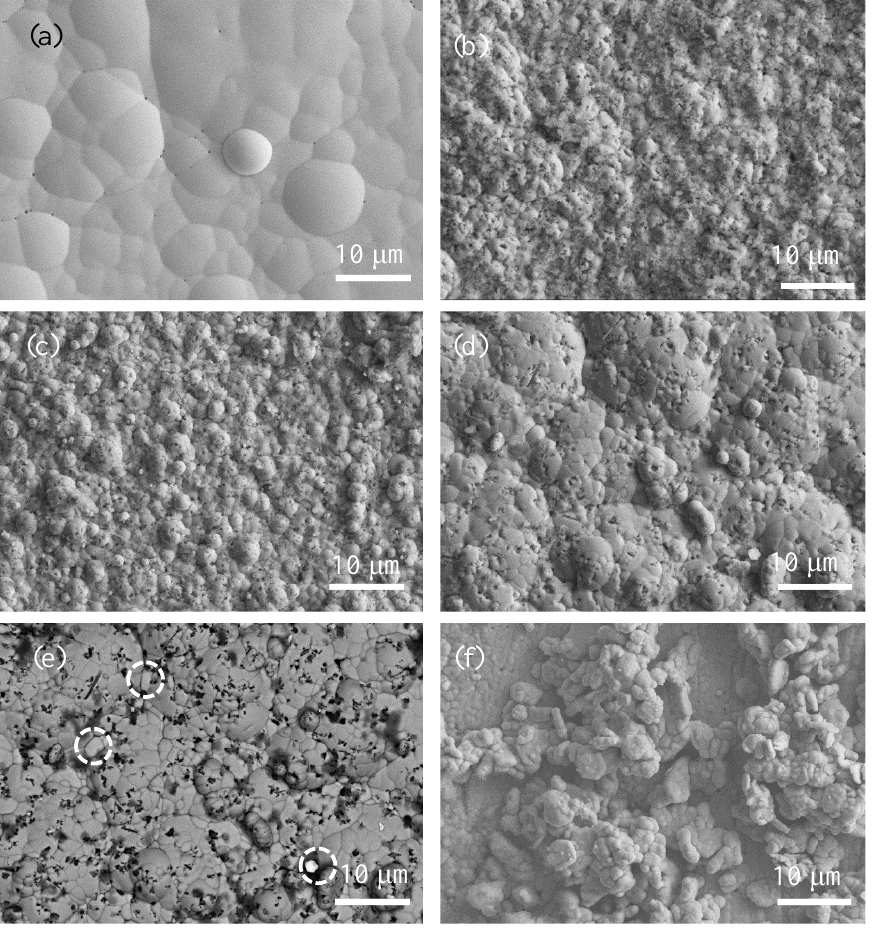
Figure 2. Surface morphologies of as-plated coatings: ( a ) Ni-P (SE); ( b ) Ni-P-Si 3 N 4 (SE); ( c ) Ni-P-Si 3 N 4 -WS 2 , 1.5 g/L (SE); ( d ) Ni-P-Si 3 N 4 -WS 2 , 2.5 g/L (SE); ( e ) Ni-P-Si 3 N 4 -WS 2 , 2.5 g/L (BSE), WS 2 particles in white circles; ( f ) Ni-P-WS 2 , 2.5 g/L (SE).